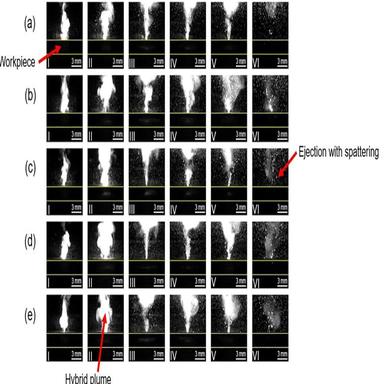
High-speed camera images showing the transient evolution of the blind-hole drilling stage using the first laser pulse under different ultrasonic powers of (a) 0 W, (b) 156 W, (c) 311 W, (d) 467 W and (e) 622 W.